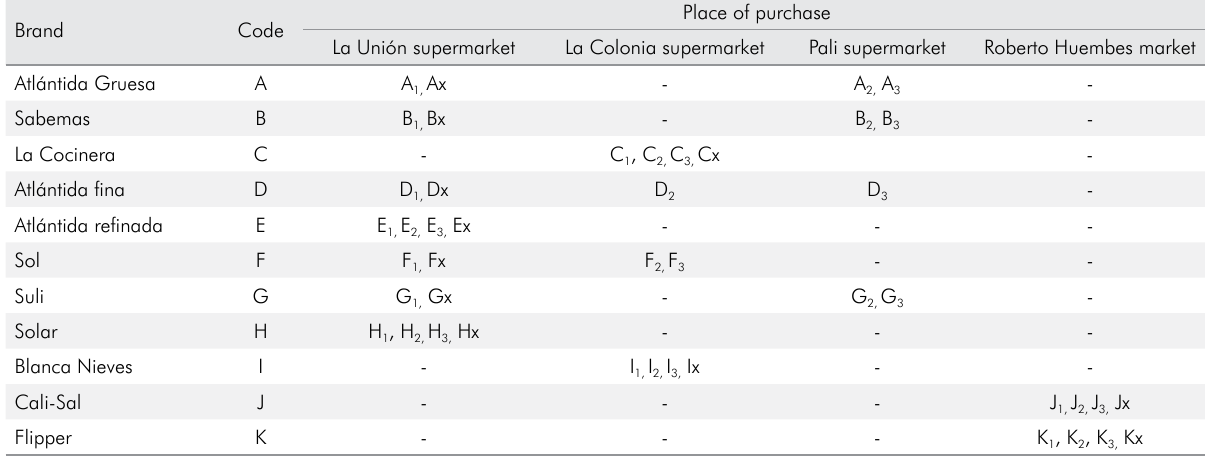
Table 1. Salt brands according to place of purchase and coding.